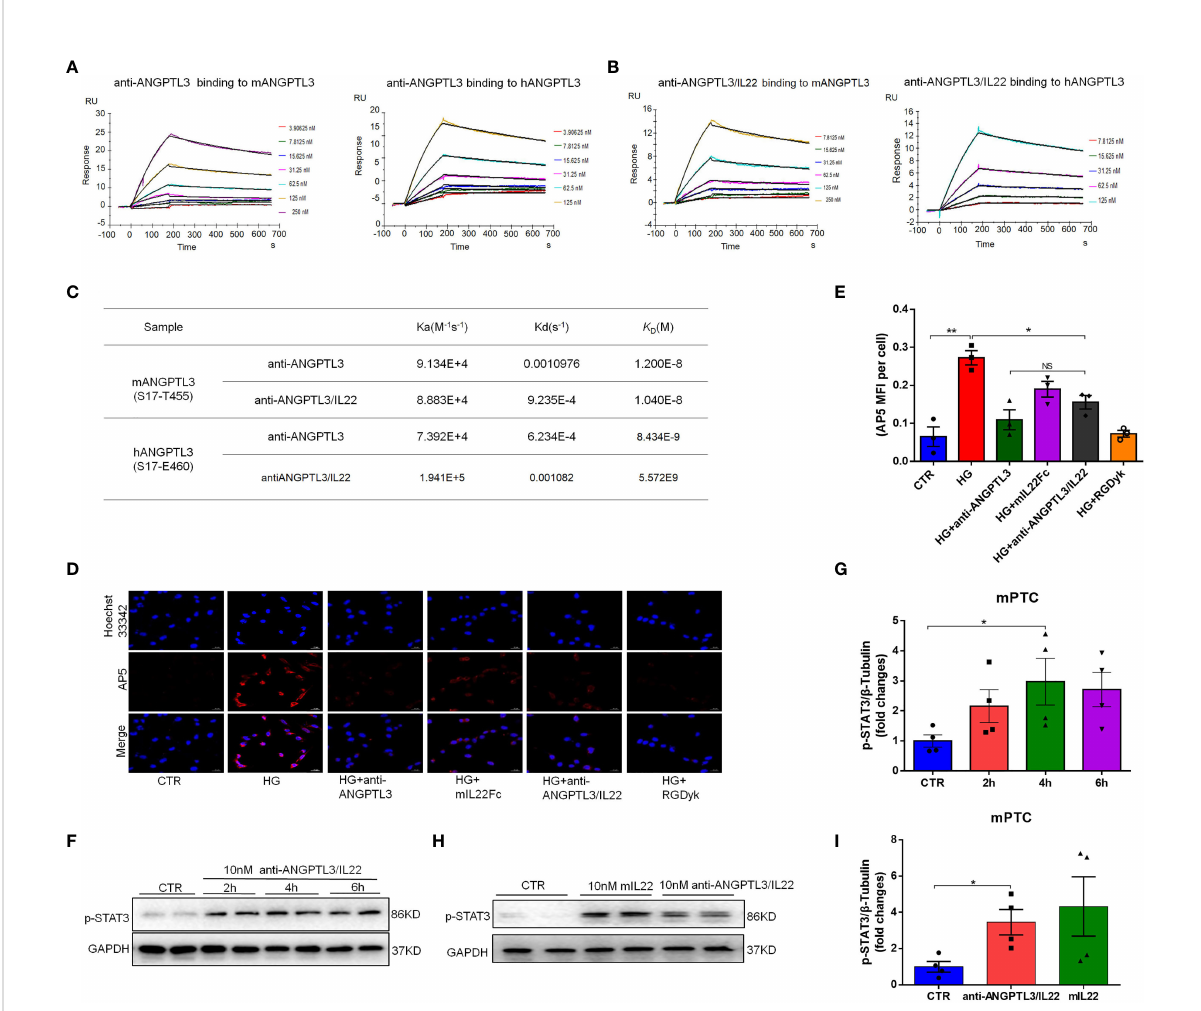
FIGURE 2 Af fi nity of anti-ANGPTL3 and anti-ANGPTL3/IL22 for ANGPTL3 and the validation of in vitro activity. (A) Af fi nity of anti-ANGPTL3 for mouse (S17- T455) and human (S17-E460) ANGPTL3 measured by surface plasmon resonance (SPR). (B) Af fi nity of anti-ANGPTL3/IL22 for mouse and human ANGPTL3 measured by SPR. (C) Af fi nity summaries of anti-ANGPTL3 antibody and anti-ANGPTL3/IL22 fusion protein suggested that the functional integrity of anti-ANGPTL3 was preserved. (D) Mouse podocytes (MPC5) were fi rst incubated with anti-ANGPTL3, mIL22Fc, anti- ANGPTL3/IL22 and FGDyk for 1 hour, followed by the addition of high concentration glucose (30 mmol/L) for 6 hours. Then, the cells were stained with AP5 and Hoechst 33342 to assess intracellular exposed PSI epitopes. (Scale bar: 20 m m). (E) Statistical analysis of AP5 levels by immuno fl uorescence staining (n = 4). (F) After mouse proximal tubular epithelial cells (mPTC) were incubated overnight, 10 nM anti-ANGPTL3/ IL22-induced phosphorylation of STAT3 (p-STAT3) was analyzed by Western blot at different times. (G) Densitometric values of p-STAT3 expression after 2 h, 4 h and 6h. (n = 4). (H) Western blot analysis of p-STAT3 induced by 10 nM mIL-22Fc or anti-ANGPTL3/IL22 in mPTC for 6 hours. (I) Densitometric values of p-STAT3 expression after 6 hours of intervention. (n = 4). * P < 0.05; ** P < 0.01; NS, no signi fi